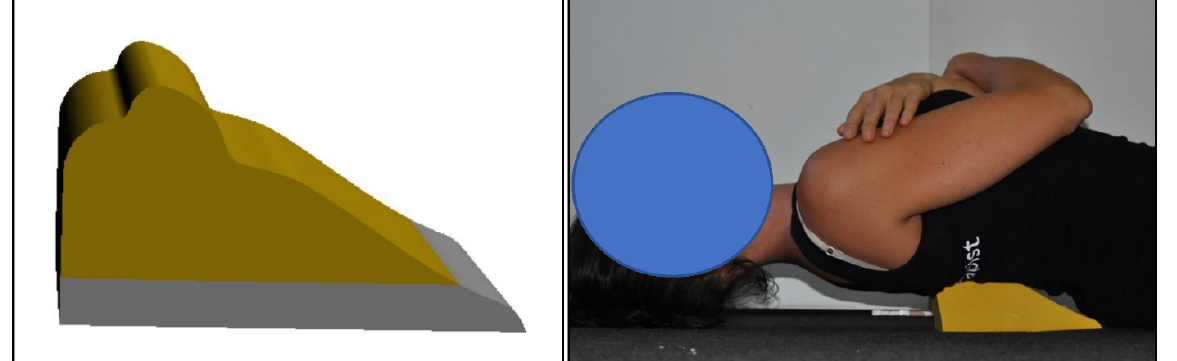
Figure 3. Denneroll™ Thoracic Traction Orthosis (DTTO). The DTTO can be placed in the upper (T3–T4), mid thoracic spine (T5–T8) ‐ shown in B; or lower thoracic region (T9–T12) pending the apex of a participant’s thoracic kyphosis and sagittal balance alignment. Each participant began lying supine over the apex of the DTTO for 1–3 min and progress 1–3 min per session until the target of